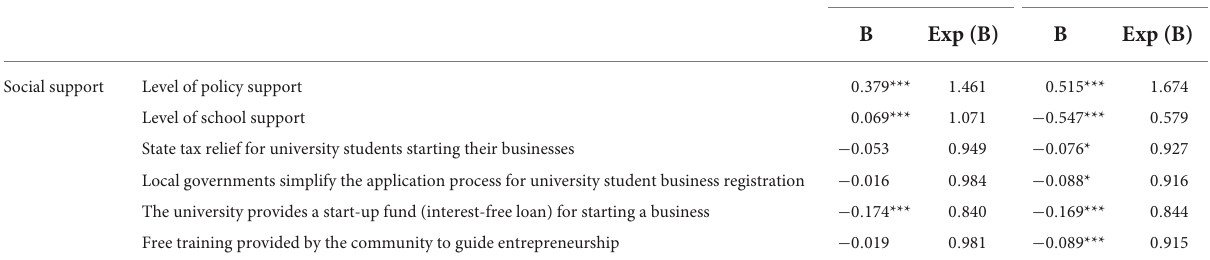
TABLE 7 Results of the regression analysis of social support factors on the dependent variable.